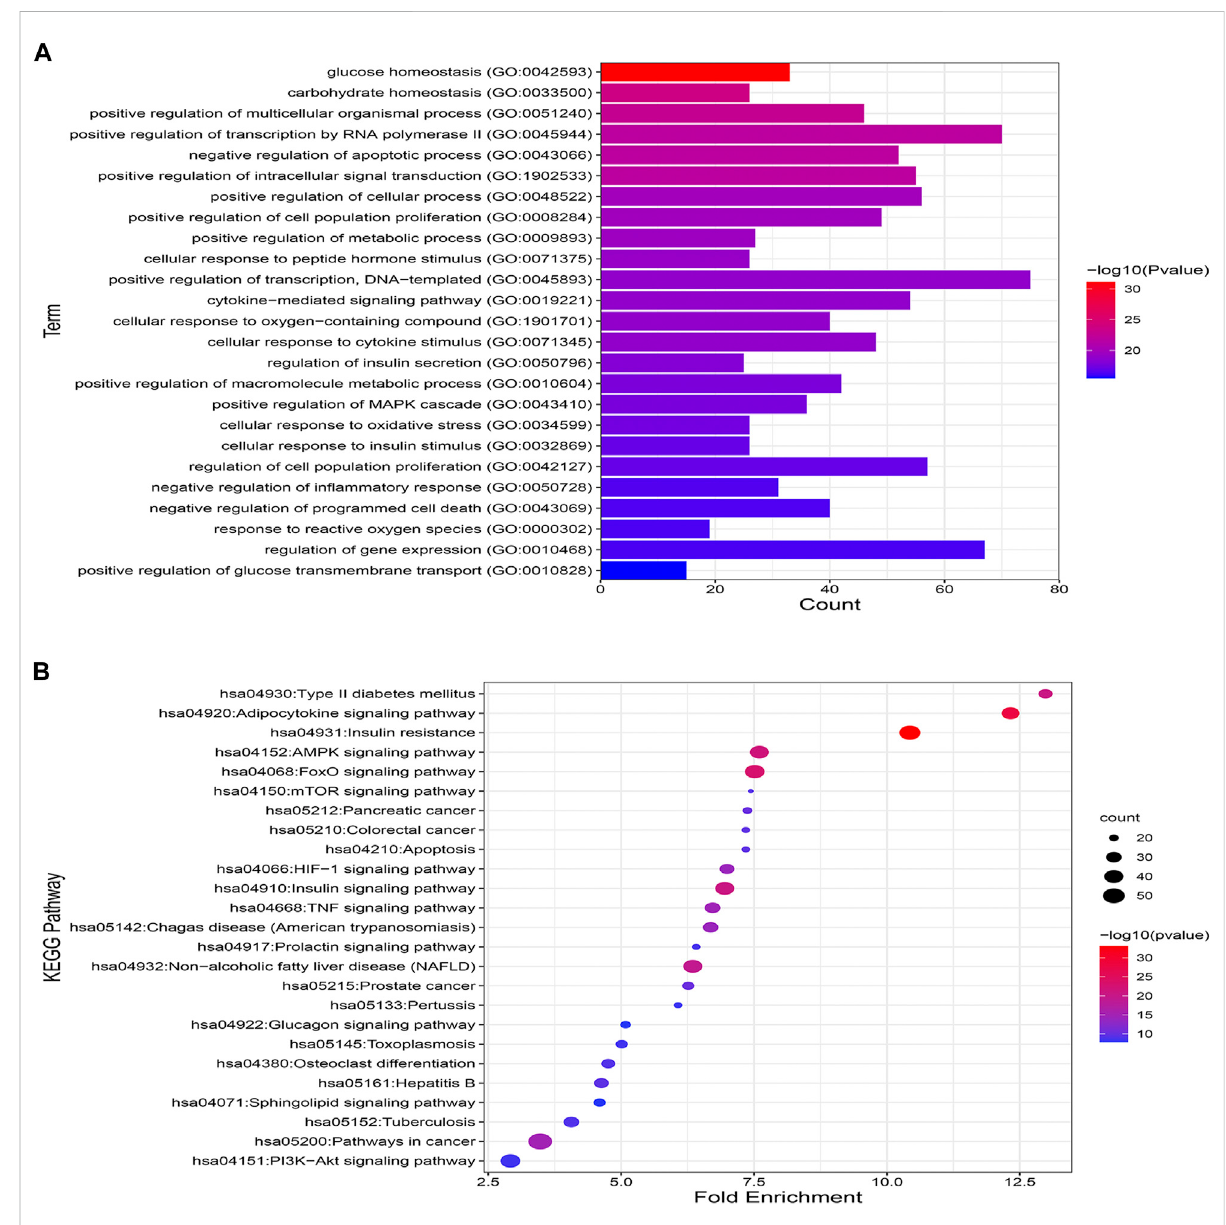
FIGURE 7 GO and KEGG pathway enrichment analyses (A) represents the top 25 enriched GO biological processes terms. (B) Represents the top 25 enriched KEGG pathways. Adjusting the size of the images and resolution, adding the panels ’ letters, and combining the images was carried out using